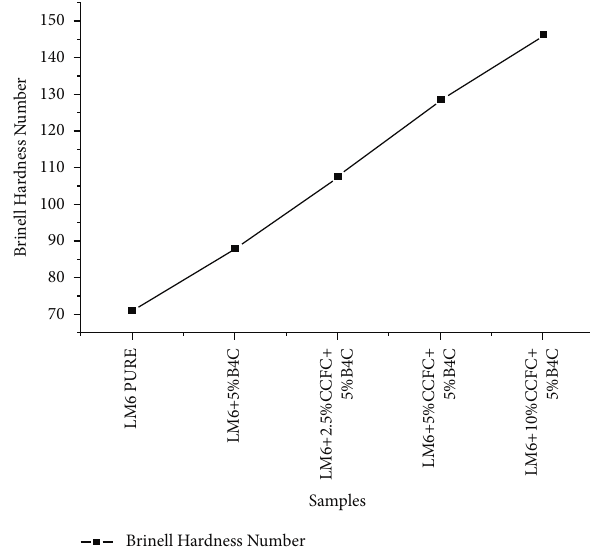
Figure 7: Changes of hardness against wt. % of strengthening.